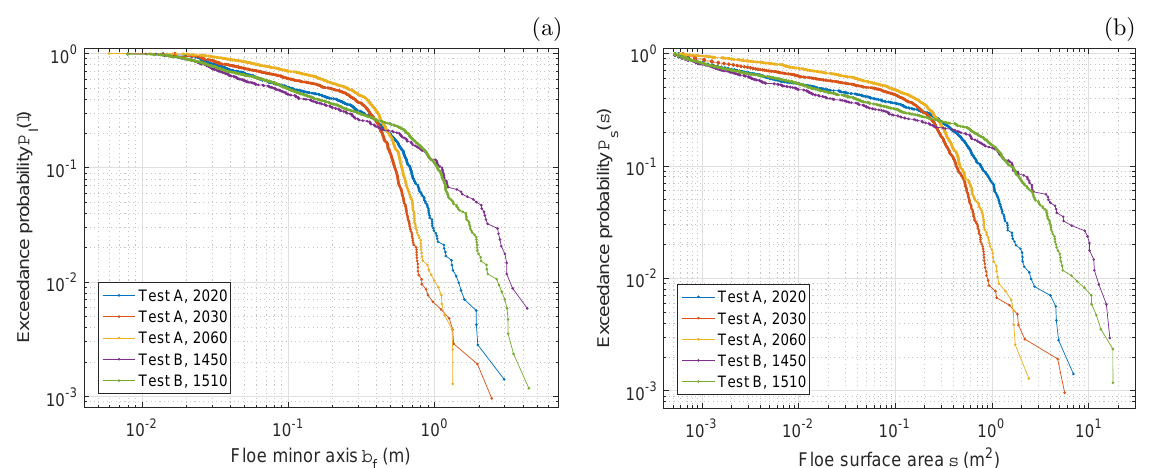
Figure 6. Log–log plots of the exceedance probability P l (l) (a) and P s (s) (b) for unbinned data from all five tests, for floes larger than 5 × 10 − 4 m 2